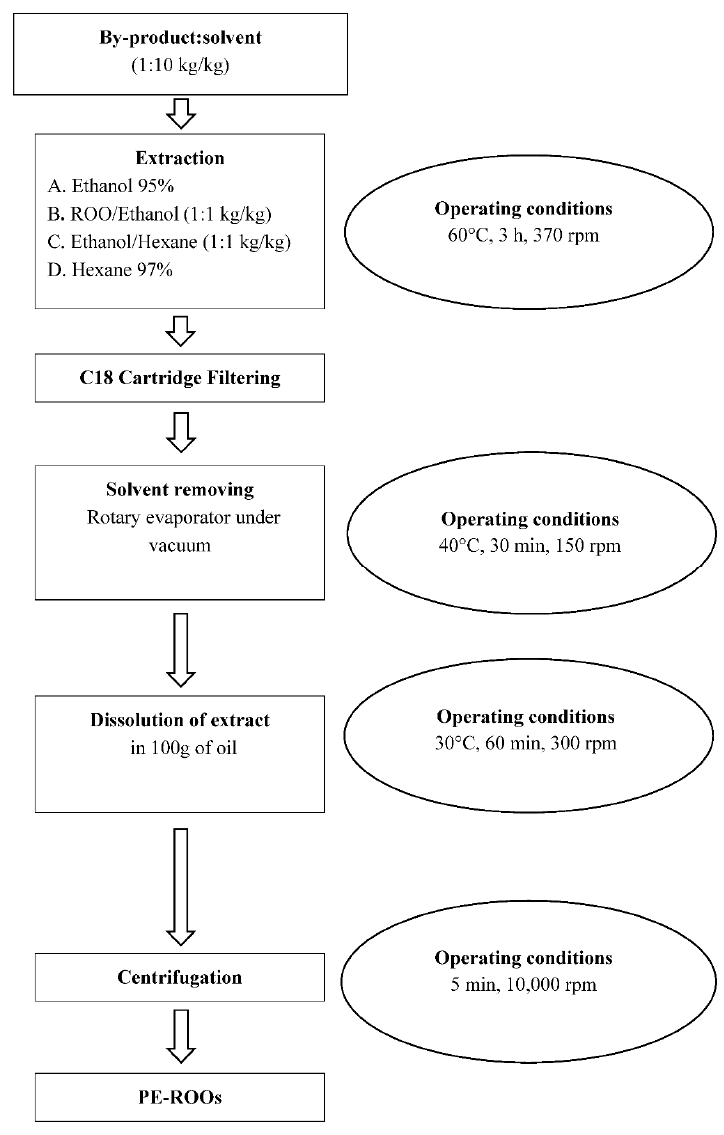
Figure 1. Experimental setup in which all extraction phases (extraction, filtering, solvent removing, dissolution, centrifugation, final product) and operating conditions (time, temperature, and extraction speed) of the recovery of antioxidant compounds from different by-products (olive pomace, olive leaves, and grape marc) are shown.